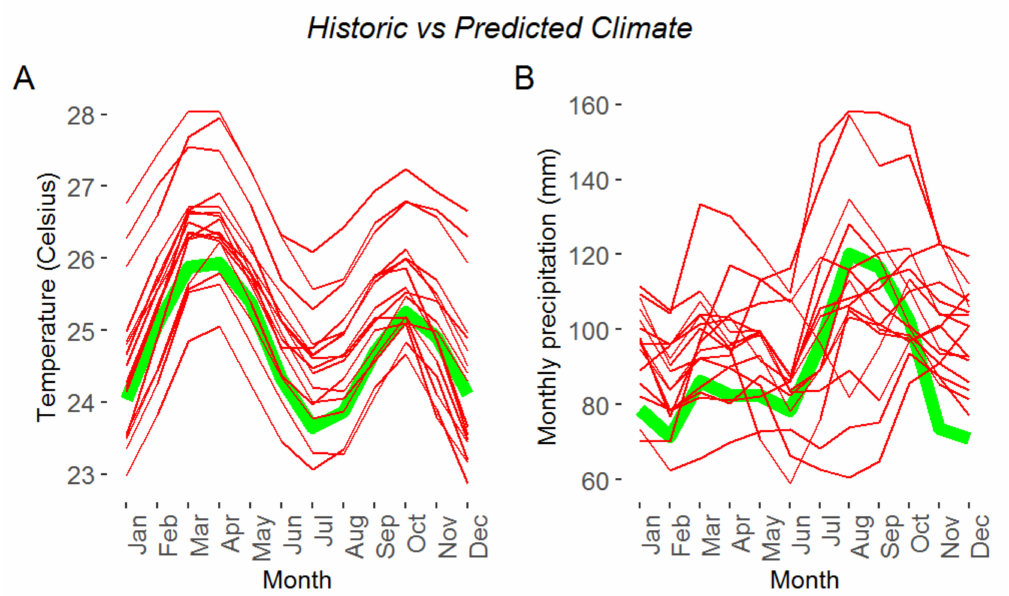
Figure 2. Historic and predicted (2020–2039, RCP 2.6) ( A ) temperature and ( B ) precipitation. The green tick line shows average monthly data from 1991 to 2016. Thin red lines are the outcome of multiple models predicting average monthly data from 2020 to 2019 under Representative Concentration Pathway 2.6 (RCP2.6). RCP2.6 assumes that global annual greenhouse gases (GHG) emissions (measured in CO 2 -equivalents) peak between 2010–2020, with emissions declining substantially thereafter. (Source: World